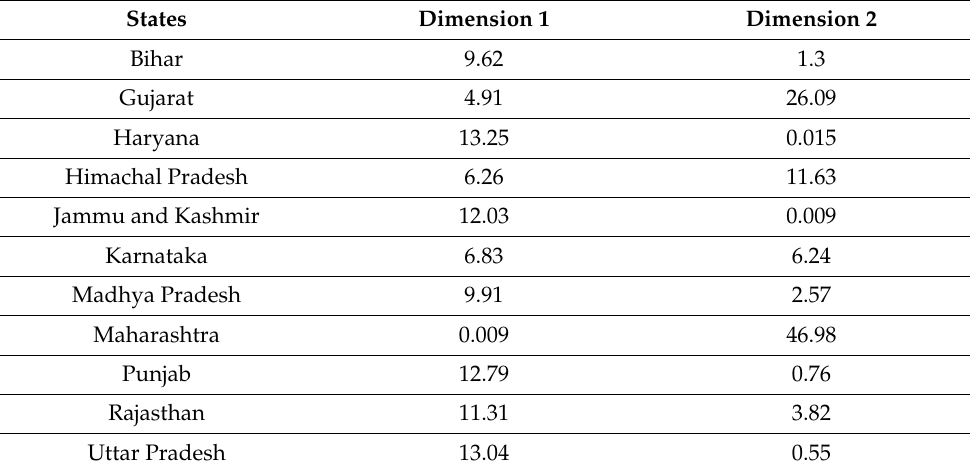
Table 1. Area principal